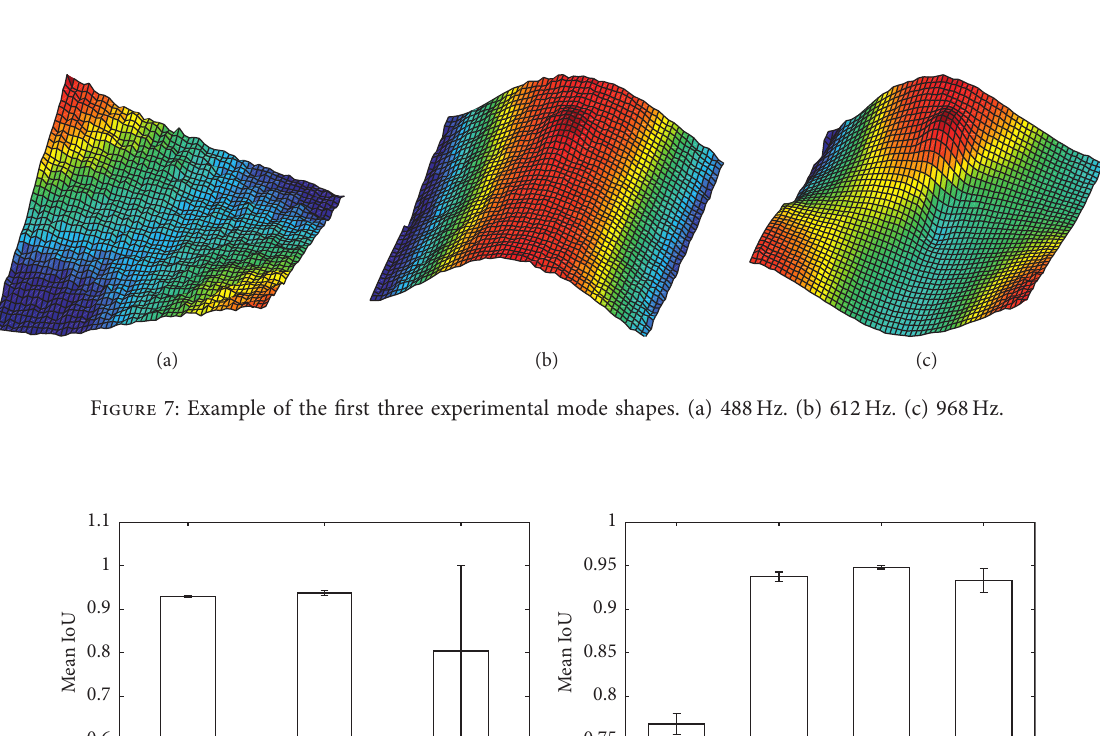
Figure 6: Experimental setup: (a) panel with the speckle pattern and (b) shaker attachment.